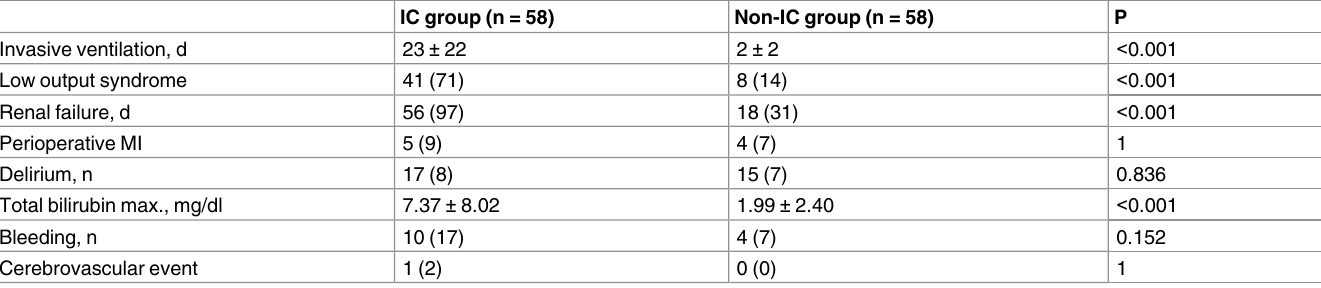
Table 3. Postoperative Data.